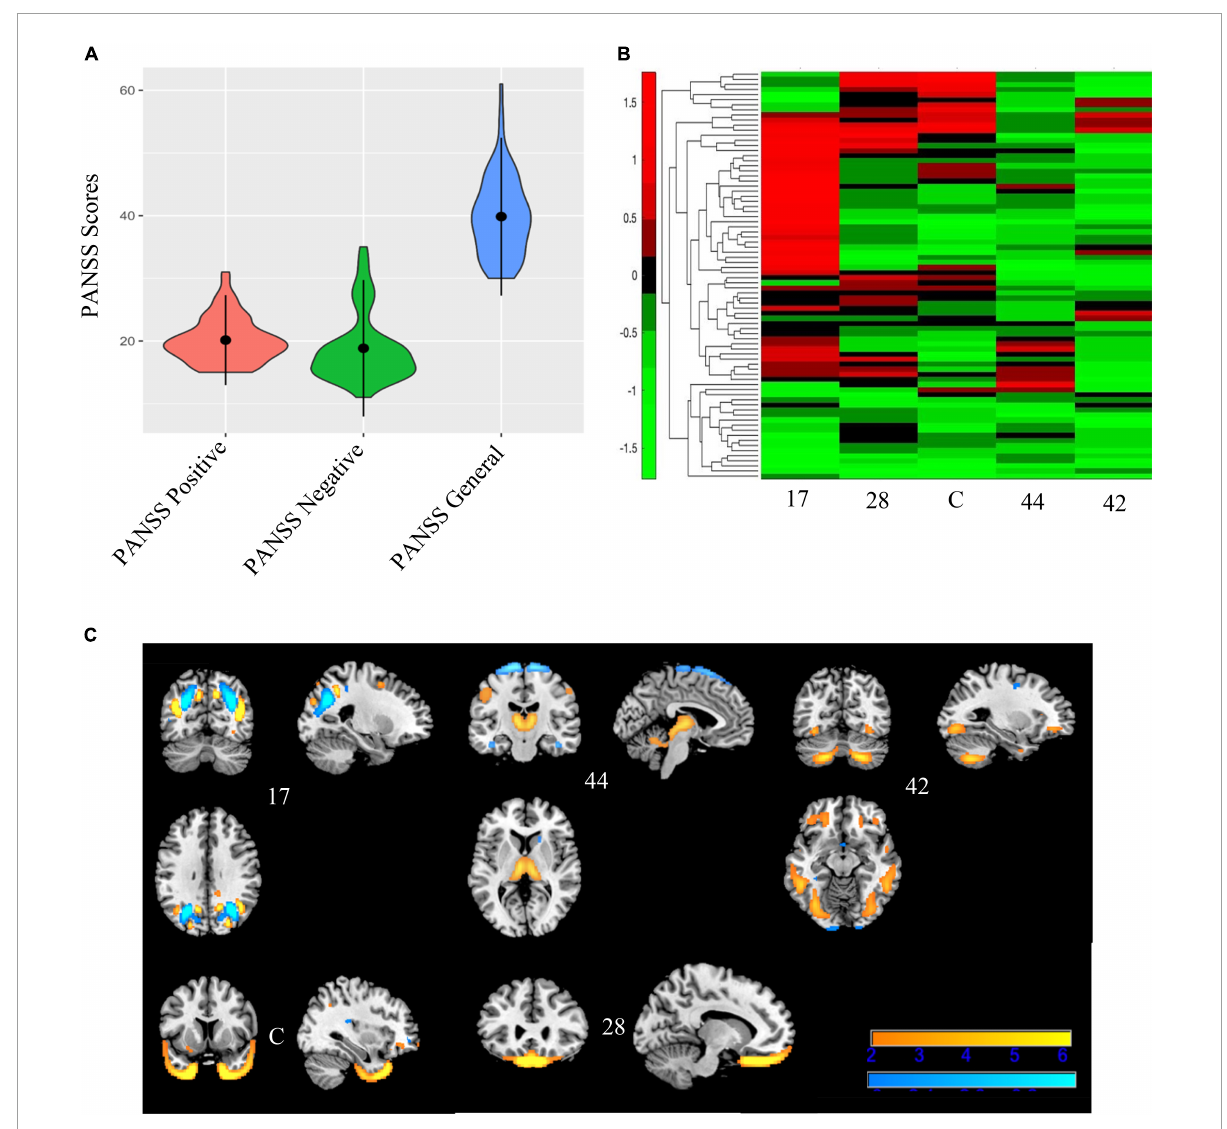
FIGURE6 Bicluster 1: PANSS scores, heat map of loadings of independent component analysis (ICA) components, and ICA components. Bicluster 1 ( N = 80) had more severe scores on all three PANSS subscales (A) than the rest of the sample. This bicluster included 5 ICA components (17, 44, 42, C, and 28) representing the occipital lobes, rectus, cerebellum, and the temporal poles that were generally low in the loading coefficients (B) . Images in (C) 6C are thresholded at |2.5|. Warm colors represent positive values and cool colors represent negative